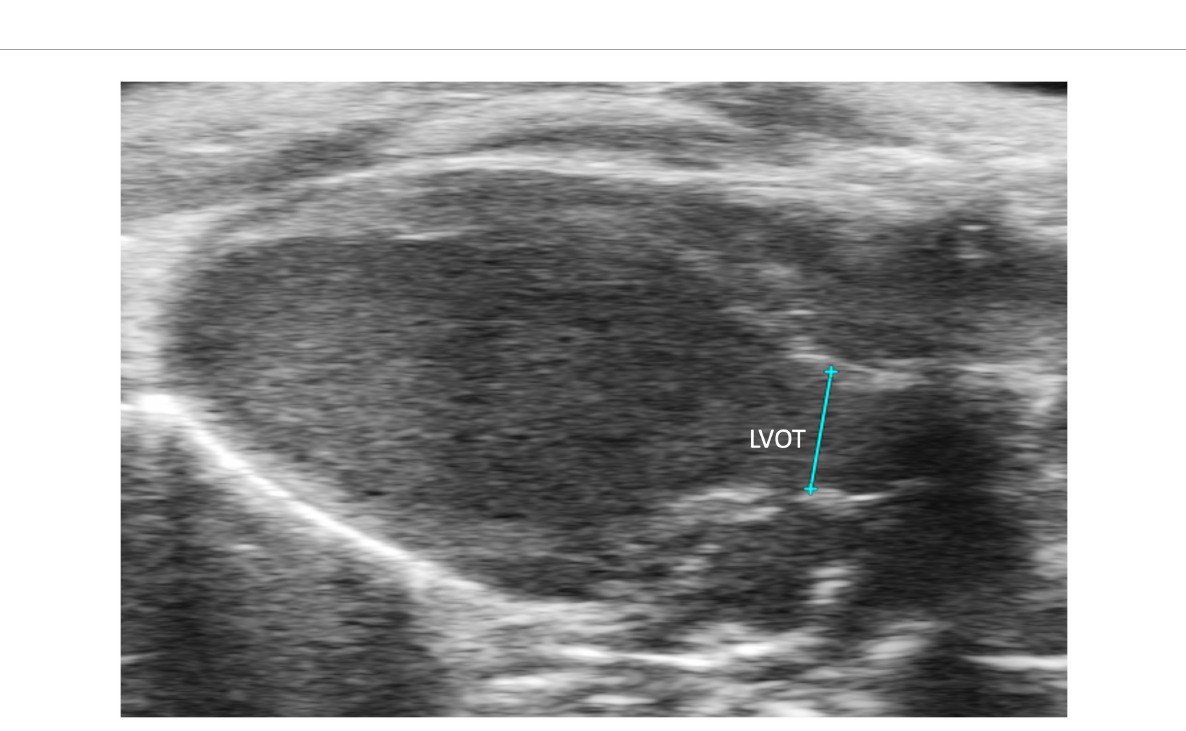
FIGURE9 The left ventricular outflow tract (LVOT) length is acquired in the B-mode of the parasternal long axis view